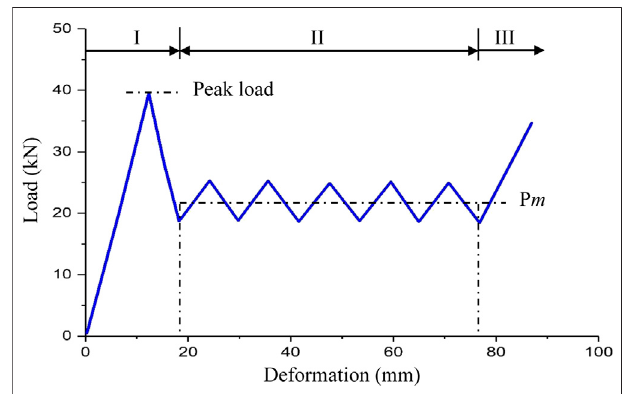
FIGURE 2 | Typical force-displacement graph (Rabiee and Ghasemnejad,